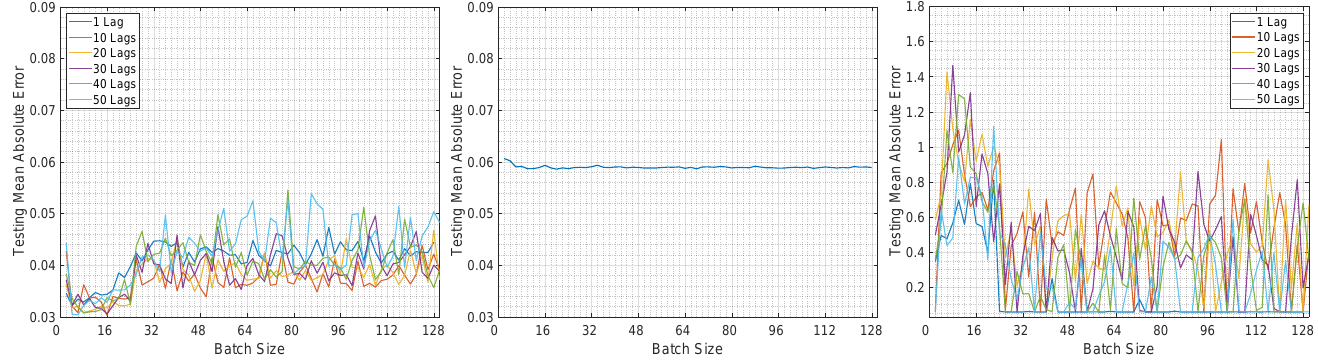
Figure 8. Illustration of the testing mean absolute error value for Experiment 2, LSTMTF ( left ), VLSTM ( middle ), and LSTMTFC ( right ), using a many-to-many prediction mode.